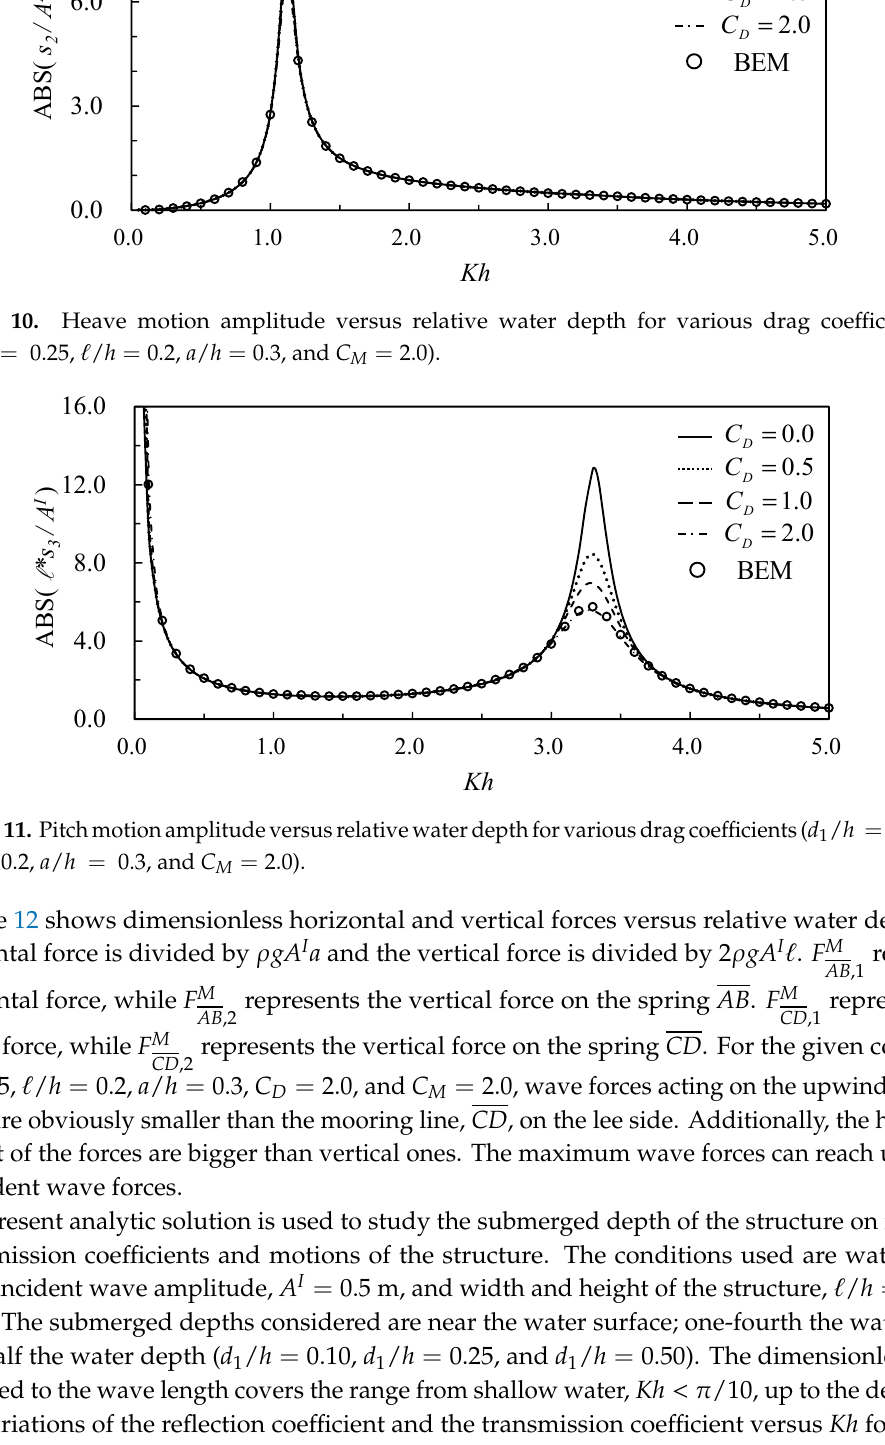
Figure 12. Wave forces on the mooring lines versus relative water depth (